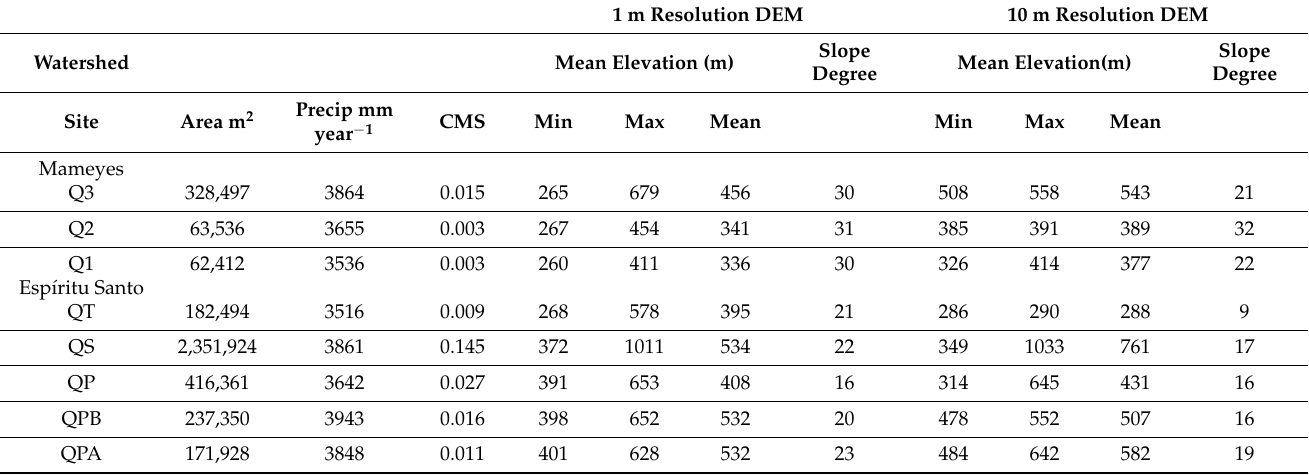
Table 1. Zonal statistics for watersheds delineated using 1-m and 10-m resolution DEMs. Notes: Cubic meters per second (CMS) is mean annual discharge (following Pike and Scatena 2008 [27]), mean annual precipitation is derived from the model presented in Murphy et al. 2017